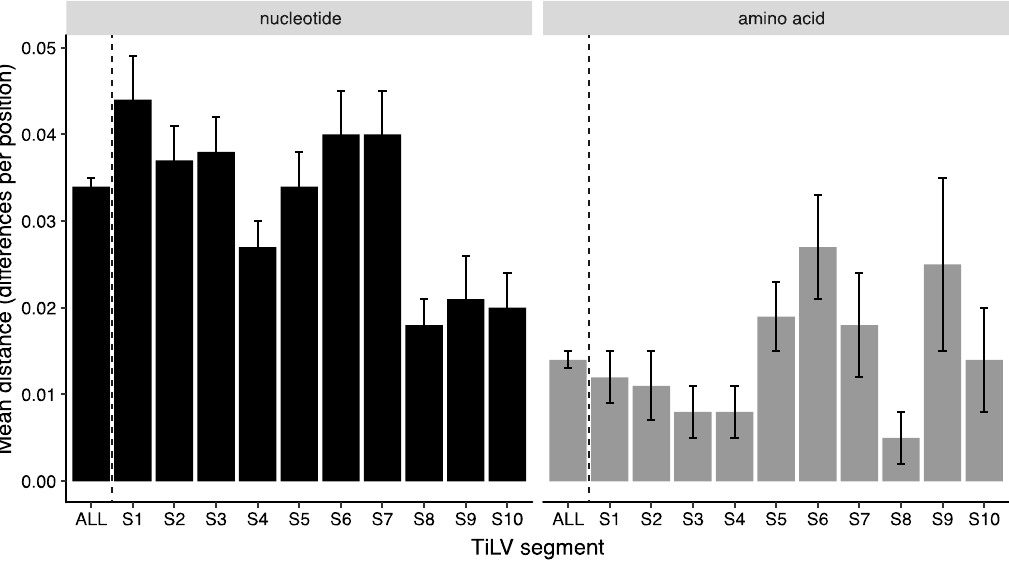
Figure 1. Mean TiLV nucleotide and amino acid distance (differences per position), based on alignment of the full coding regions of seven genomes from Israel, Thailand, Ecuador, Peru and Bangladesh. Error bars show estimated variance based on 1000 bootstrap replicates, and models of nucleotide substitution for each segment are as listed in Figure 4.